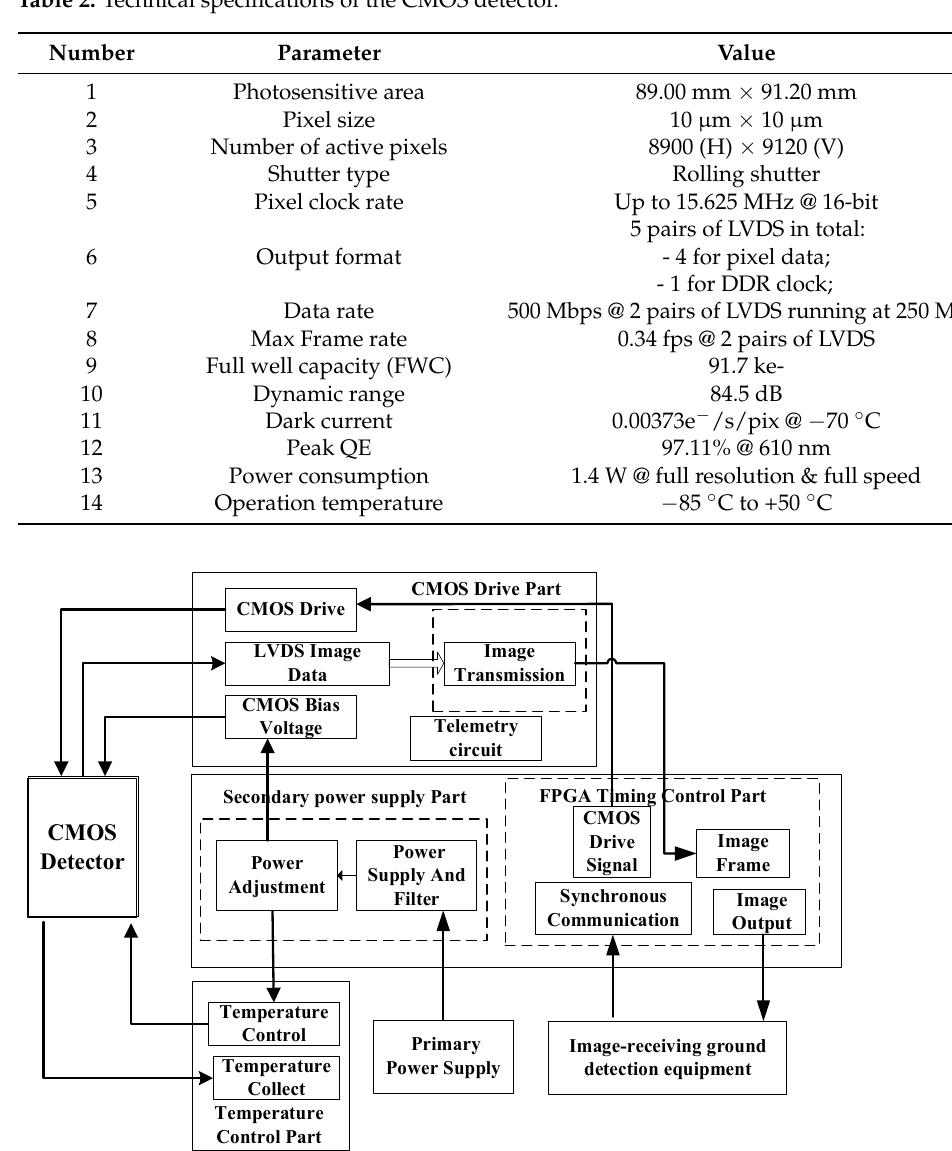
Table 2. Technical specifications of the CMOS detector.